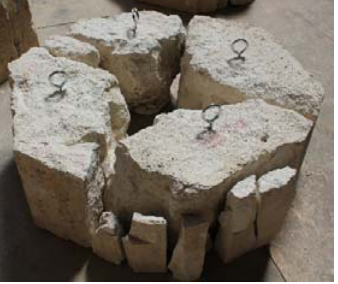
Figure 13. Pillar n. 11 – row 1. It is evident the external deterioration of the stone, in good condition in the inner